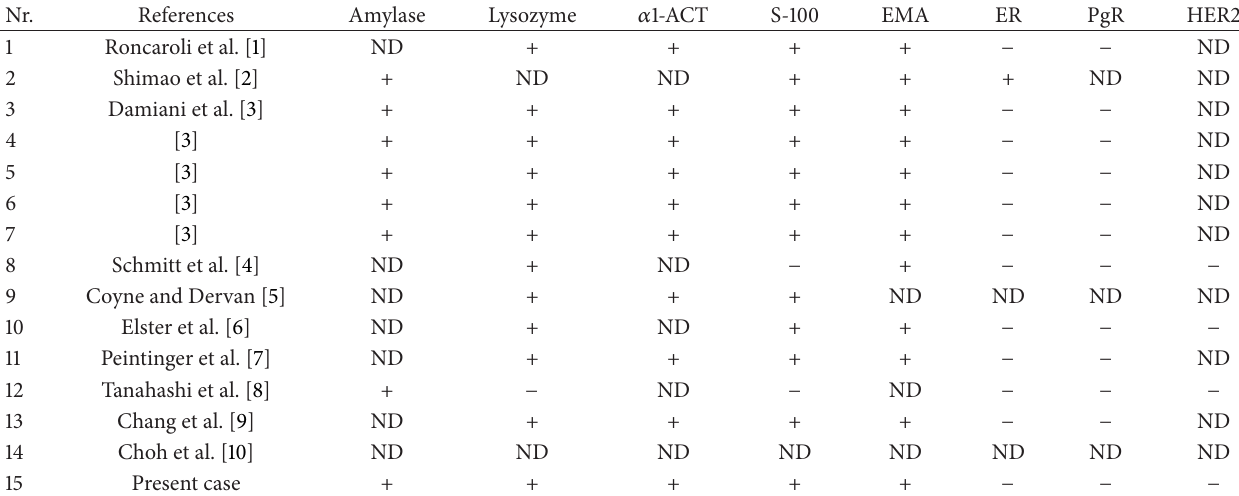
Table 2: Immunohistochemical characteristics of acinic cell carcinoma of the